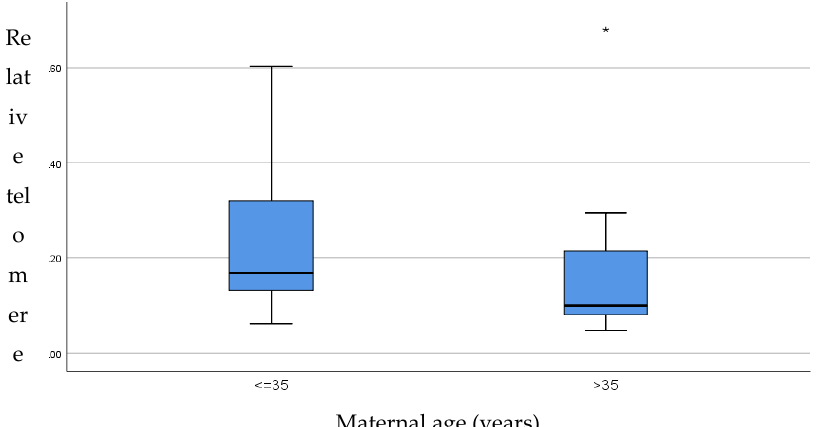
Figure 7. Relative telomere length of aneuploid first polar bodies in women aged 35 years or younger ( n = 8) in comparison to woman over the age of 35 ( n = 12). Results show no significant difference between the groups ( p = 0.89). The line on the lower end of the whisker represents the minimum T/S ratio, the bottom of the box represents the first quartile, the line through the middle region of the box represents the median T/S ratio, the top of the box represents the third quartile and the line at the top of the whisker represents the maximum T/S ratio. Circles represent outliers between 1.5 and 3 box lengths from the upper region of the box. Asterisks represent extreme outliers that are more than three times the interquartile range from the third quartile. Cells 2019 , 8 , x FOR PEER REVIEW